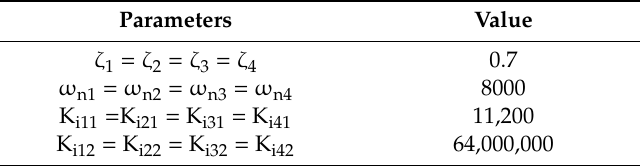
Table 2. Current control